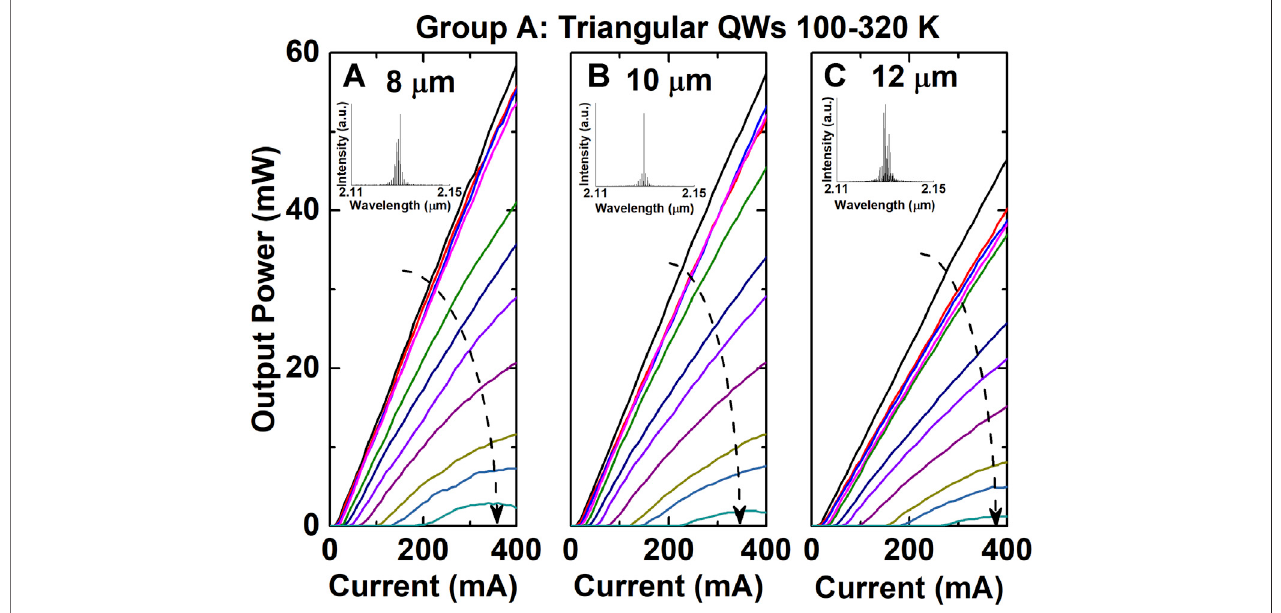
FIGURE2| Output power versuscurrentwithtemperatures from 100to320 Kfor groupA(triangularQW) lasers withridge widths of (A) 8, (B) 10, and (C) 12 μ m, respectively. The insets show the output spectra at 300 K for the three lasers at threshold current, respectively.